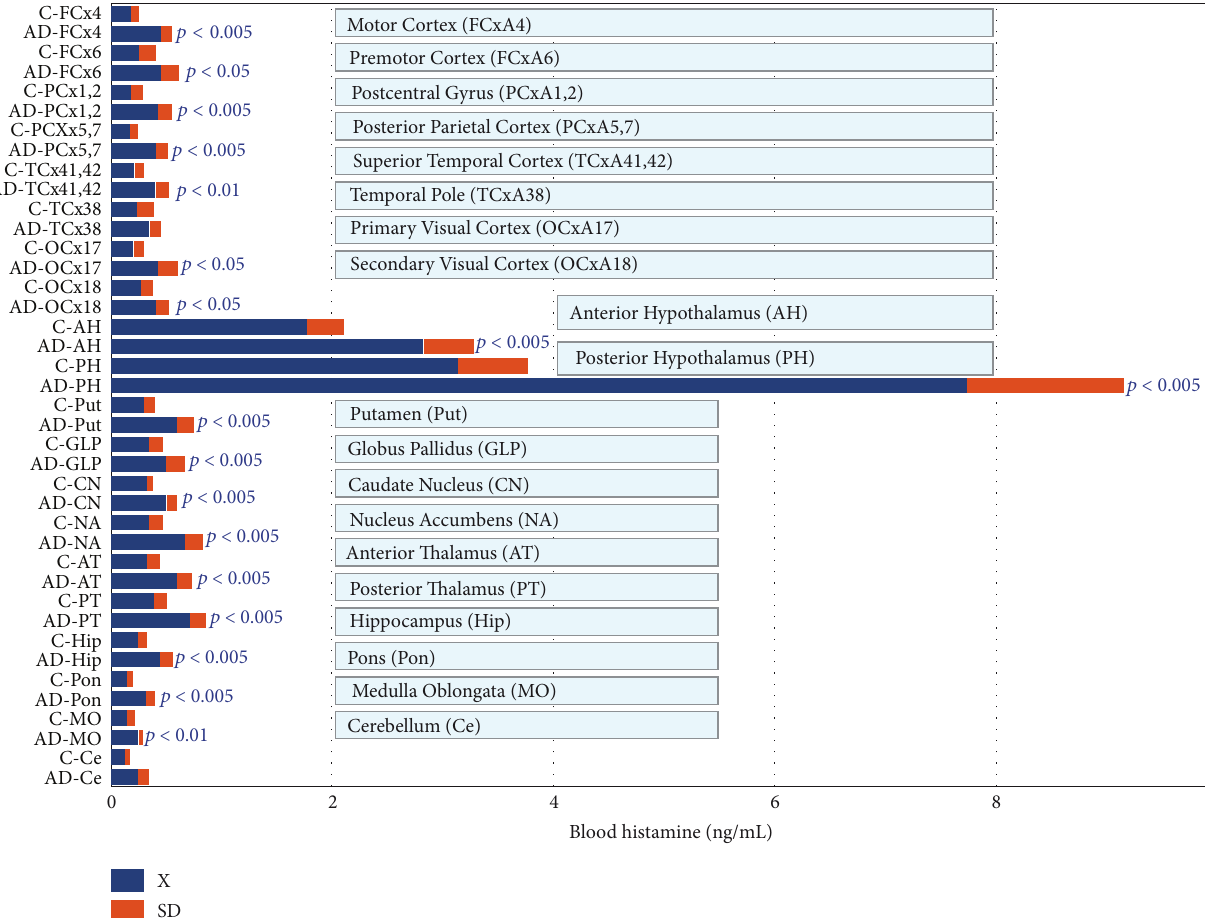
HA, TNF- 𝛼 , and IL-1 𝛽 levels in AD and in animal models of dementia [7, 25, 34–37].